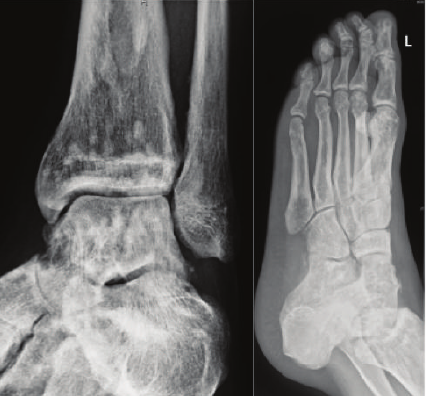
Figure 3: Radiograph of the left ankle and of the left foot showing multiple sclerotic spread lesions, observed at the lower part of the tibia and fibula, of the tarsal bones, metatarsal heads and predominant at the epiphyses of the phalanges.